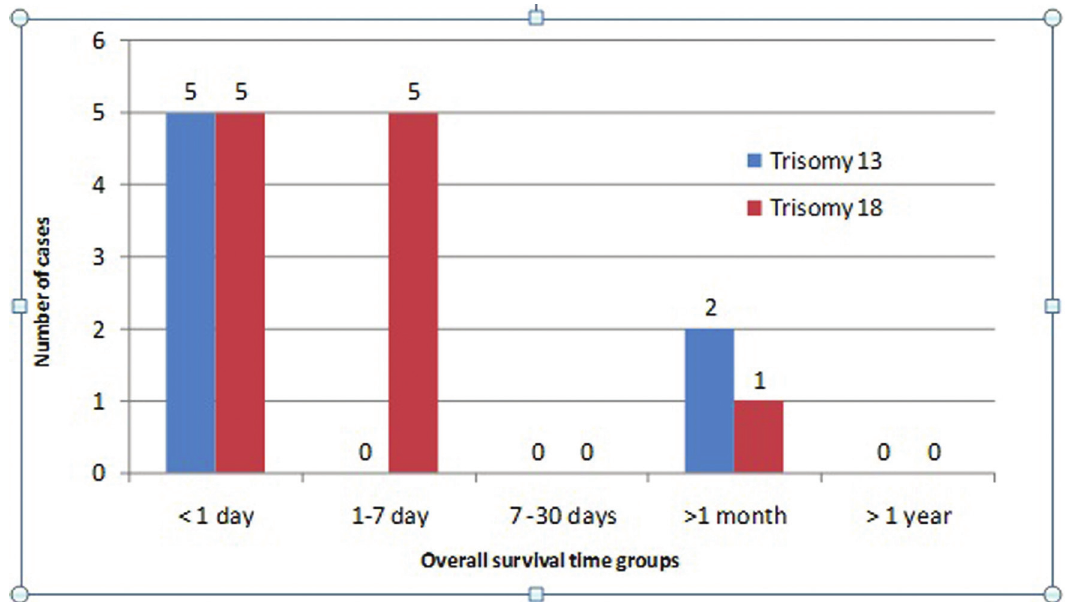
Figure 3 - Offspring death